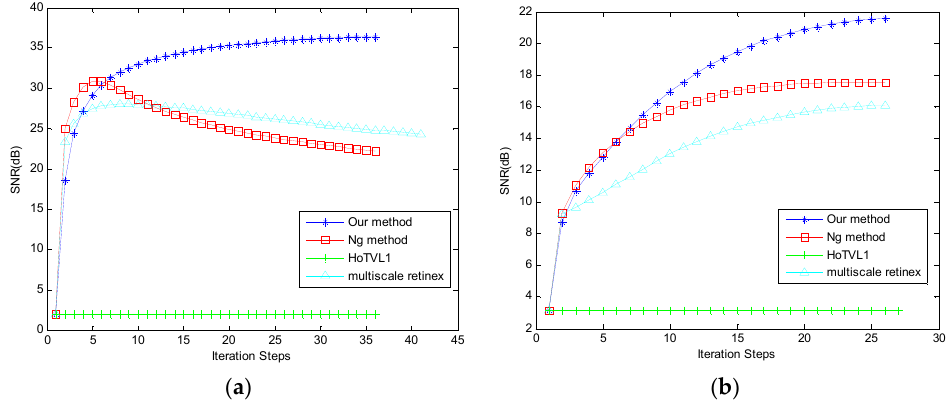
Figure 9. SNR curves. ( a ) For Figure 7a; ( b ) For Figure 7d.